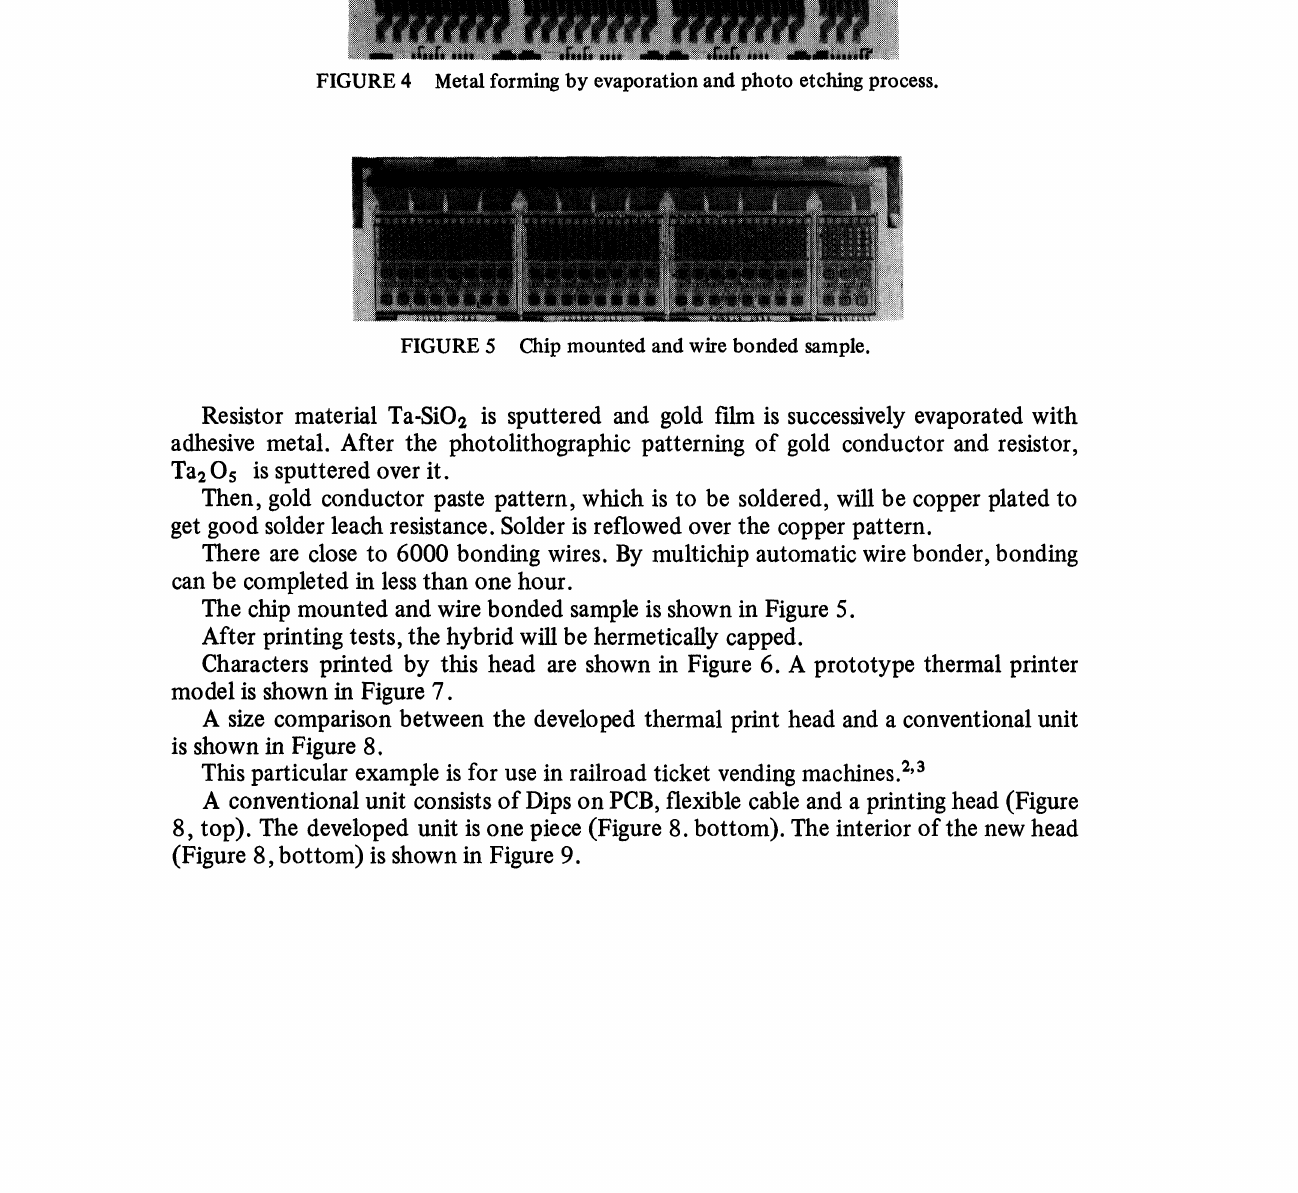
FIGURE 3 Water-proof Toshiba direct drive thermal print head cross-sectional view